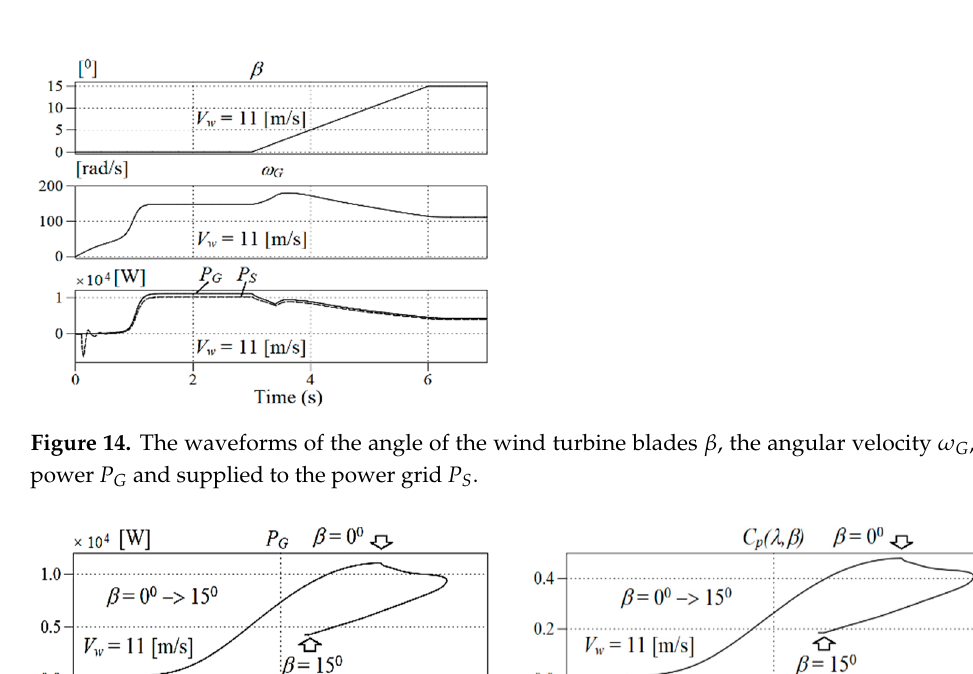
( b ) Figure 12. Waveforms of wind speed V w ( a ) 12, 8, − 8, − 12 [m/s 2 ]; ( b ) 24, 24, − 24 − 24 [m/s 2 ] generator angular speed ω G and power P G , and grid power P S , for β = 10°. ( a ) ( b ) Figure 13. Waveforms of generator power P G ( a ) and turbine power coefficient C p ( λ , β ) ( b ) for chang- ing wind speed V w and blade angle equal to β = 10° . Figures 14 and 15 show the transient processes occurring in a wind power plant dur- ing a linear change in the turbine blade angle setting in the range from β = 0 ° to β = 15 ° , at